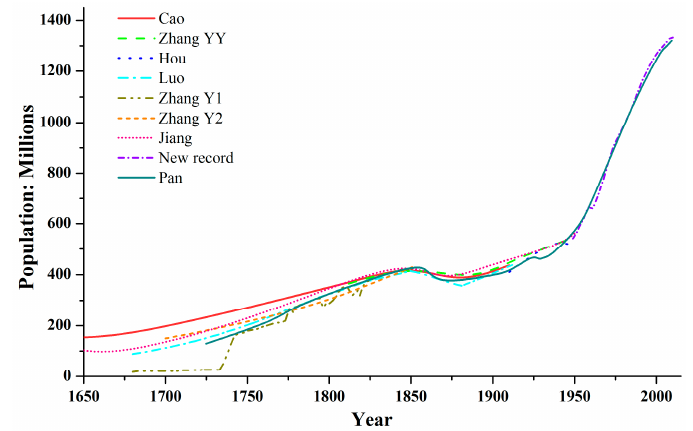
Figure 1. Historical changes of the population. Data resources: Cao [16], Zhang Y.Y. [17], Hou [18],